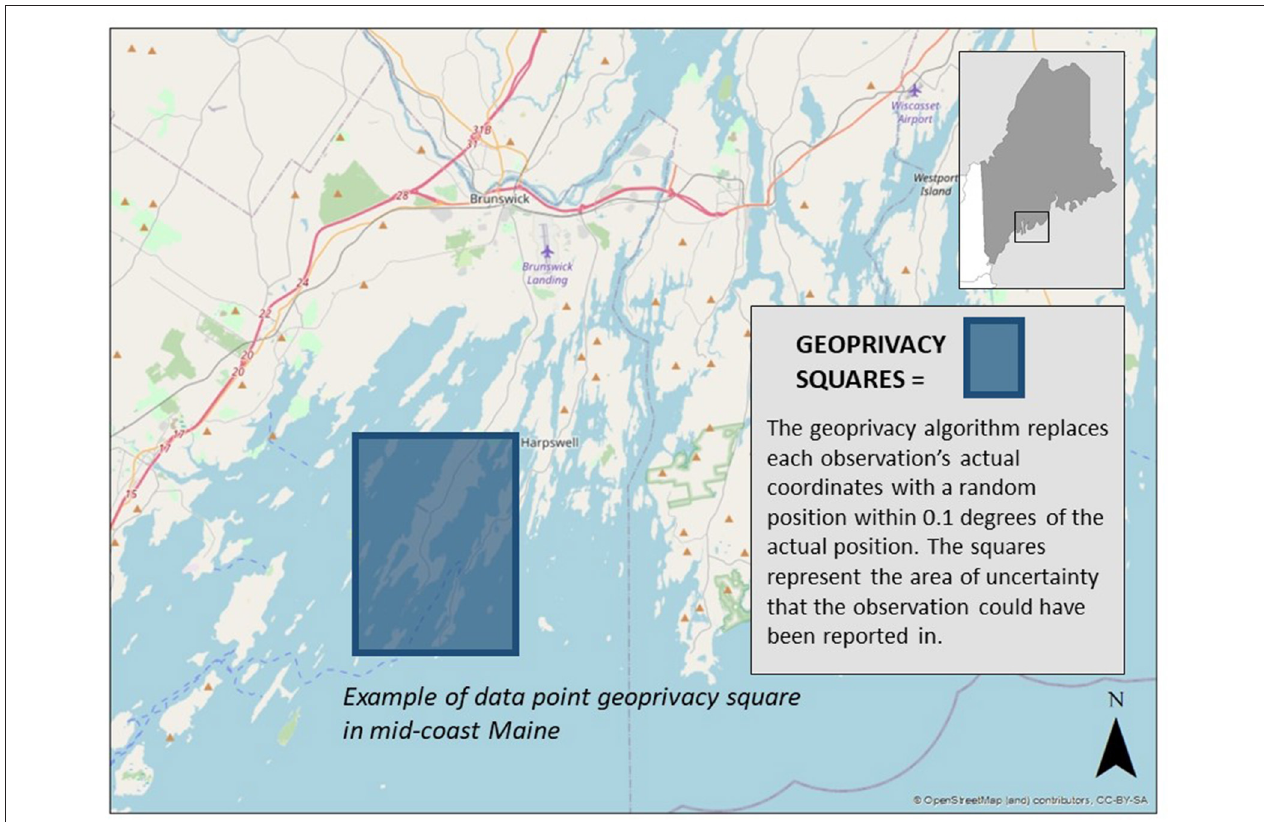
FIGURE 5 | Geoprivacy squares. All well water variables are associated with obfuscated lat/long measurements that put the data point somewhere within each square, not close enough to the actual location to reveal the address or identity of the project